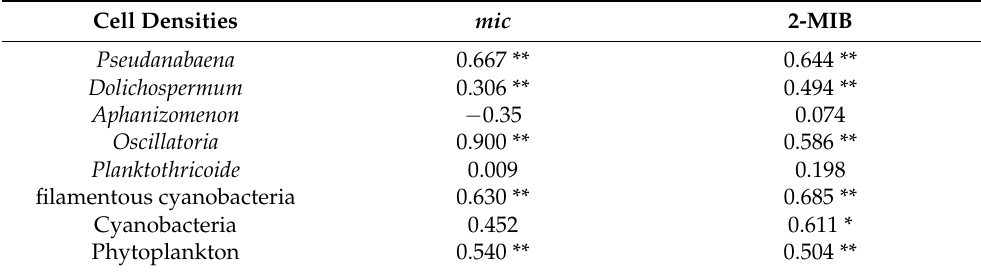
Table 1. Pearson’s correlation coefficient of cell densities of different algae, gene copies, and the concentration of 2-MIB.